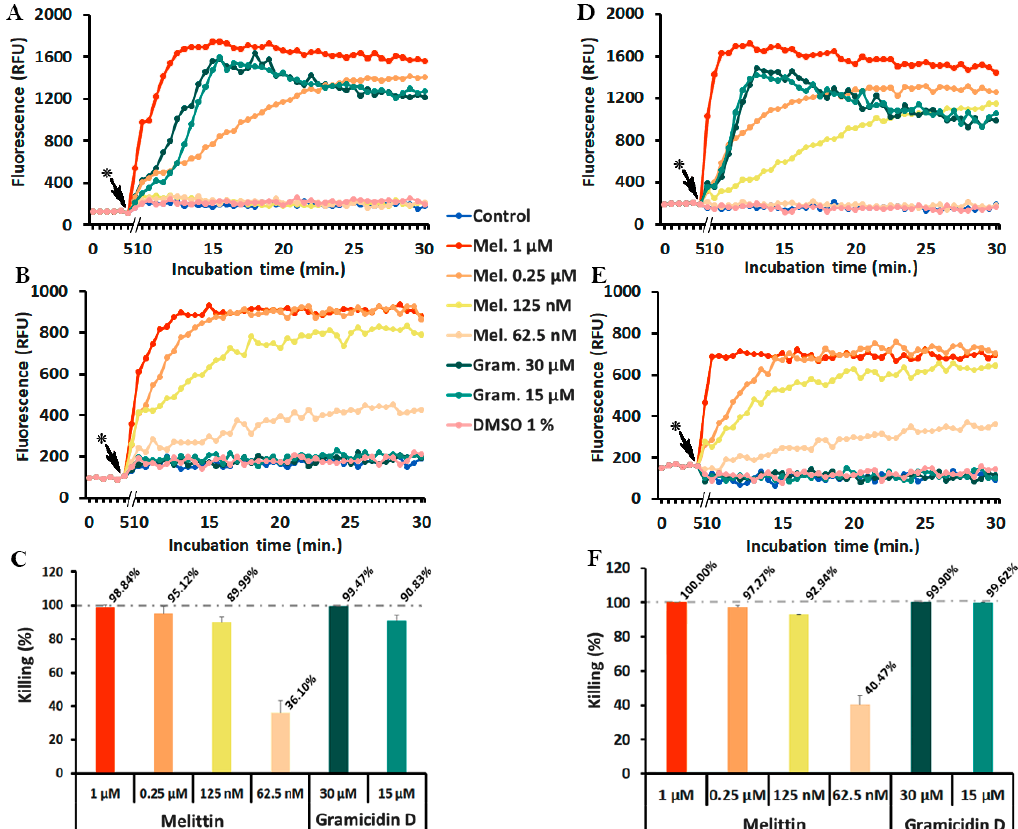
Figure 4. Membrane depolarization (diSC 3 (5)) ( A,D ), permeabilization (PI) ( B,E ) and killing ( C,F ) of S. epidermidis ( A–C ) and S. aureus ( D–F ) caused by melittin and gramicidin D. Experiments were performed with 10 8 CFU/mL of the indicated strains in PBS-glc containing 400 nM diSC 3 (5) ( λ ex = 652 nm, λ em = 672 nm) and 5 µg/mL PI ( λ ex = 535 nm, λ em = 617 nm) at 37 °C. CFU counts were determined at 30 min incubation. The kinetics of diSC 3 (5) and PI are shown in separate graphs and error bars were omitted for clarity. (*) peptide addition.